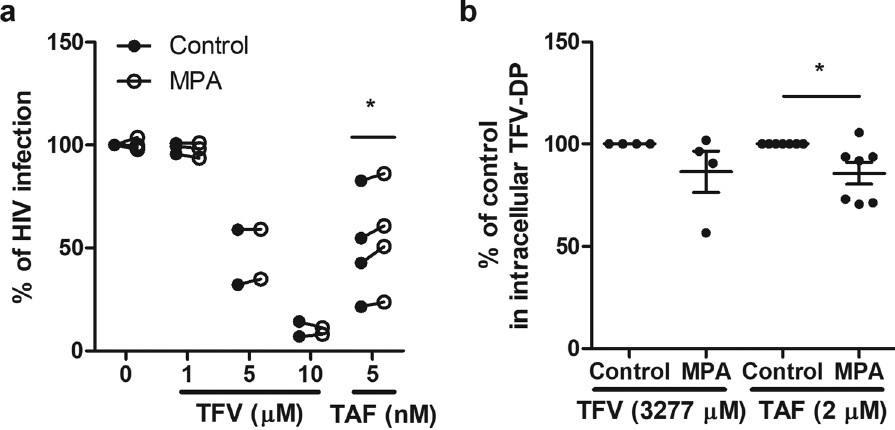
Figure 4. Effect of MPA on TFV and TAF inhibition of HIV infection and intracellular TFV-DP concentrations in endometrial CD4 + T cells. ( a ) Activated CD4 + T cells from endometrium (n = 4) were pre-treated with indicated concentration of TFV or TAF for 24hr and inoculated with HIV for 2hr. Levels of p24 released into the culture media presence or absence of MPA (1 × 10 − 7 M) at 5 days following infection were measured by p24 enzyme-linked immunosorbent assay. Data were normalized to % of HIV infection with respect to infected control without TFV or TAF pre-treatment and in the absence of MPA. Dark circles represent culture media in the absence of MPA and open circle represent culture media in the presence of MPA. Each circle represents one individual patient. * p < 0.05. ( b ) TFV-DP concentrations were measured by LC-MS/MS in purified CD4 + T cells isolated from endometrium pre-treated with MPA (1 × 10 − 7 M) for 24 h following treated with TFV (3277 µ M) and TAF (2 µ M) for 24 h. Data were normalized to % fold change from control values. Each circle represents a different patient. The mean and SEM are shown. * p <